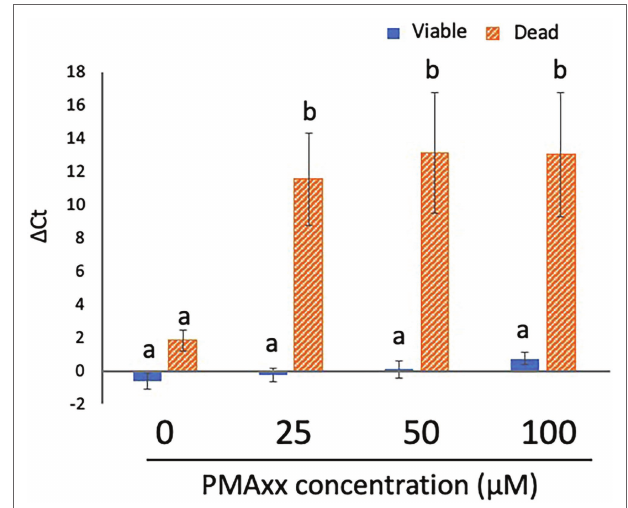
FIGURE 2 | Determination of the optimal concentration of PMA. Two hundred microliters each of viable and dead cell suspensions (concentration: 5 × 10 7 CFU/ml for both) was treated with PMA Enhancer and PMAxx at various concentrations (0, 25, 50, and 100 μ M) before DNA extraction and qPCR. The columns display the mean values from five independent experiments ± standard deviation. The different letters indicate significant differences among different groups ( p < 0.05). PMA, propidium monoazide; CFU, colony-forming unit; and qPCR, quantitative